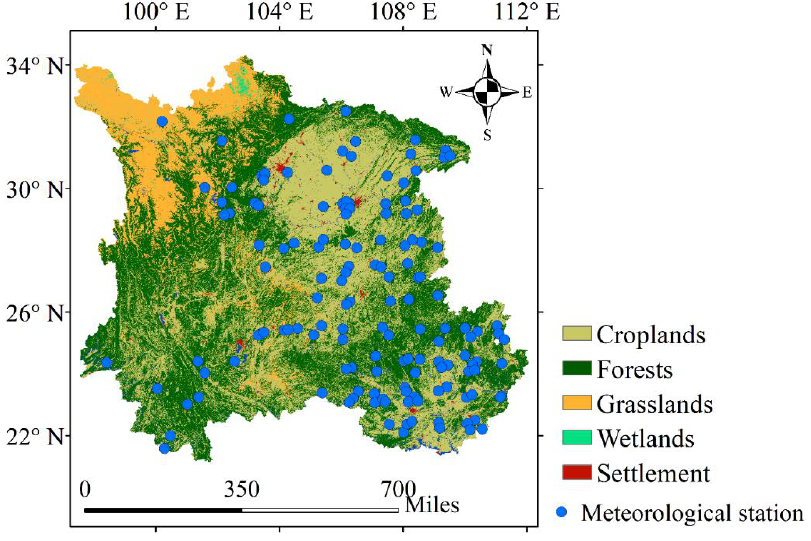
Figure 1. Land cover in our study area. The meteorological stations used for validation were also shown.